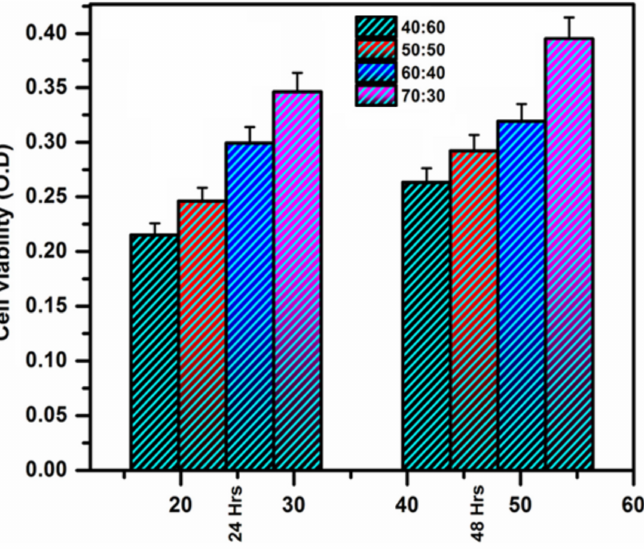
Figure 20. Cell-proliferation study (MG-63 cell line) for the PLA/CNF-HAP electrospun composites of different compositions reproduced from [264] with permission of John Wiley & Sons).